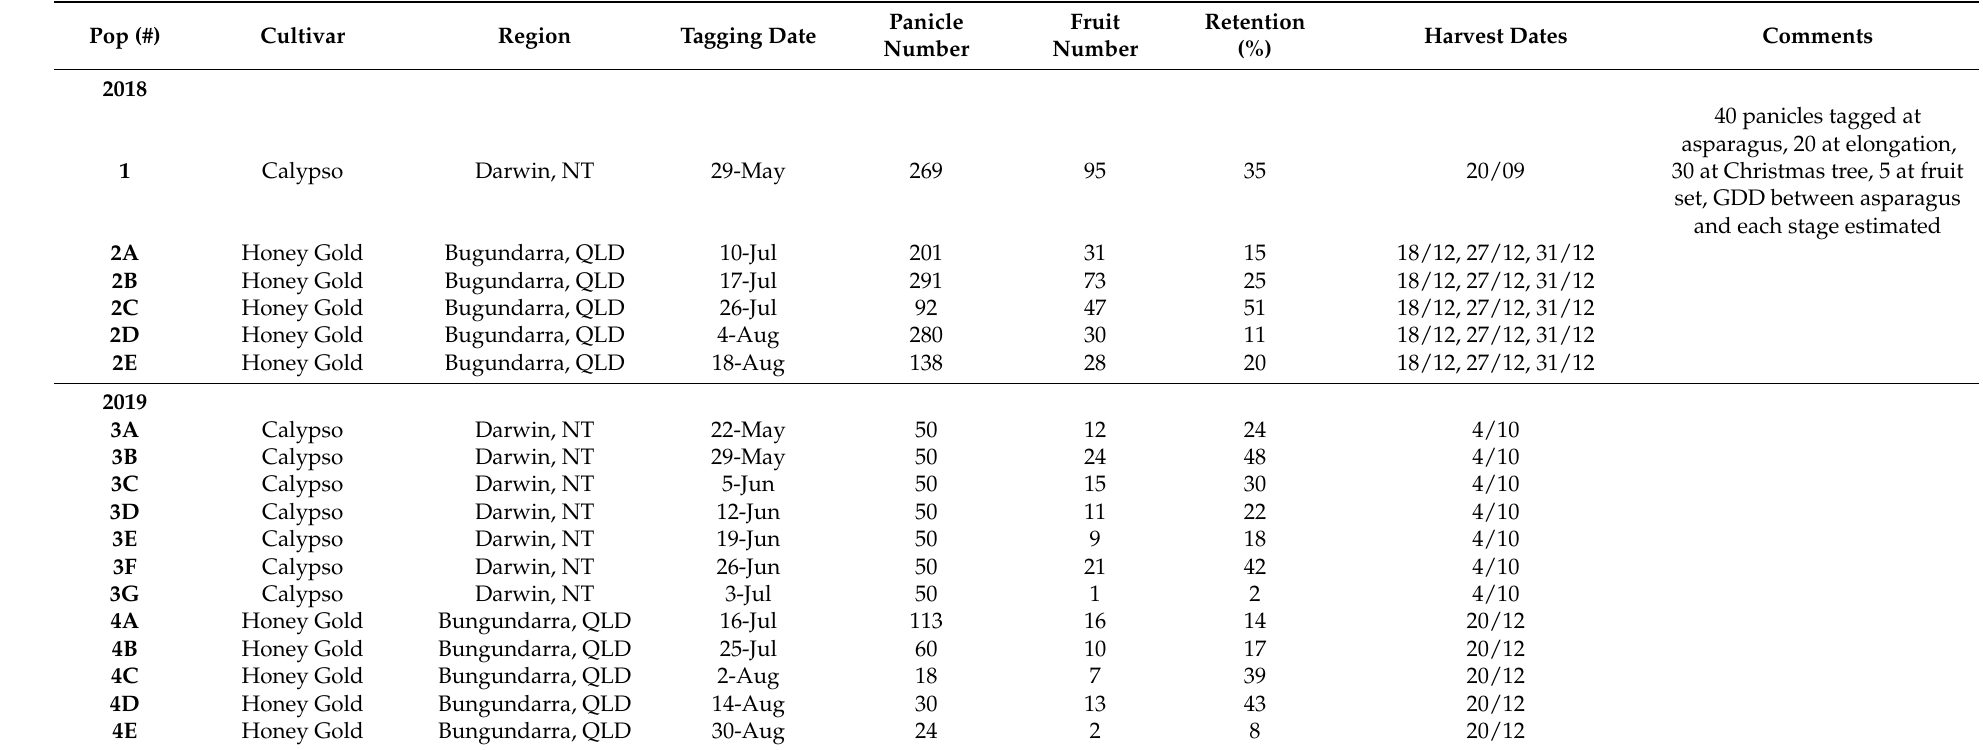
Table A1. Populations and tagging exercises across different sites and seasons. All panicles were tagged at asparagus stage except as